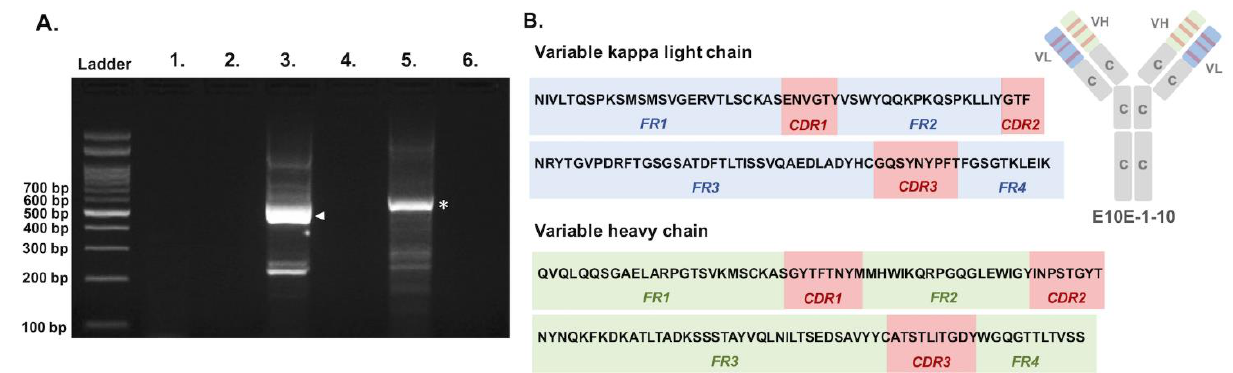
Figure 1. Sequencing of the variable regions of PEDV neutralizing monoclonal antibody, E10E-1-10. ( A ) The PCR reactions were conducted by using one general forward primer and three specific reverse primers, which target on variable lambda light chain (Lanes 1 and 2), variable kappa light chain (Lanes 3 and 4), and variable heavy chain (Lanes 5 and 6). Lanes 2, 4, and 6 were negative controls for each PCR reaction. Major bands sized about 500–600 bp were obtained from Lane 3 (the target amplicon of variable kappa light chain was labeled with arrowhead) and Lane 5 (the target amplicon of variable heavy chain was labeled with asterisk) and sent for sequencing. ( B ) Deduced amino acid sequences and the predicted FRs and CDRs of the variable kappa light chain and variable heavy chain.